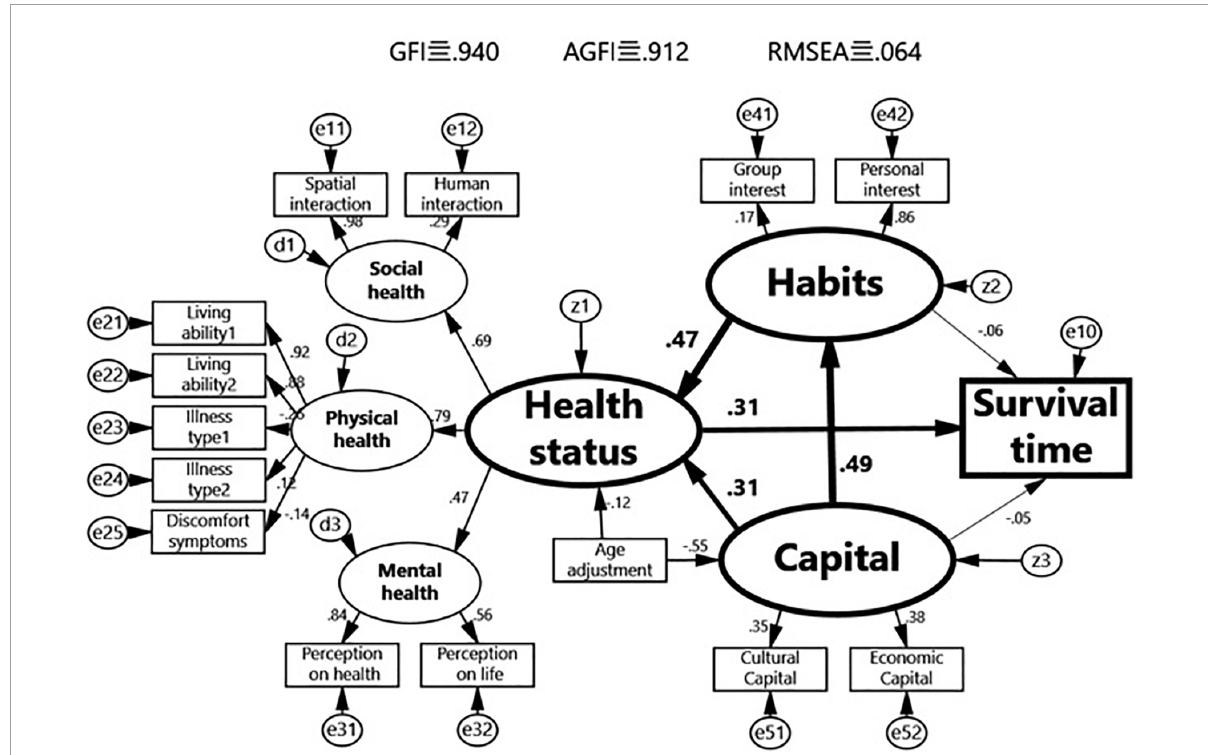
FIGURE6 Structural equation model of capital, habitus and health of the elderly in Tama City, Japan.